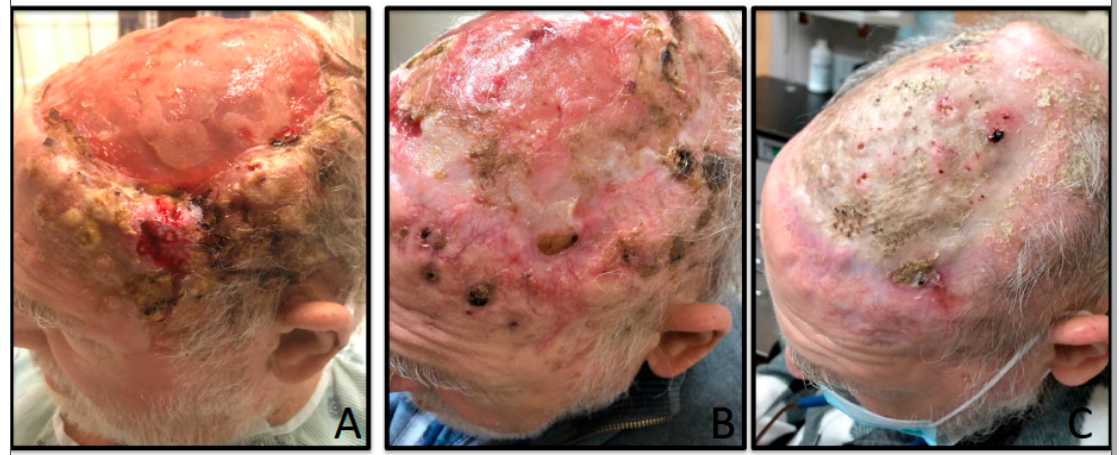
Figure 2. ( A ) Multiple nodules consistent with cutaneous squamous cell carcinoma on the left temporal area before starting cemiplimab; ( B ) tumor regression after three cycles of cemiplimab; ( C ) response after a total of 10 cycles of cemiplimab.